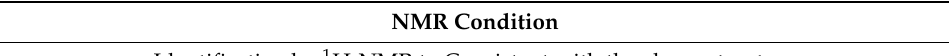
Table 3. NMR Analysis